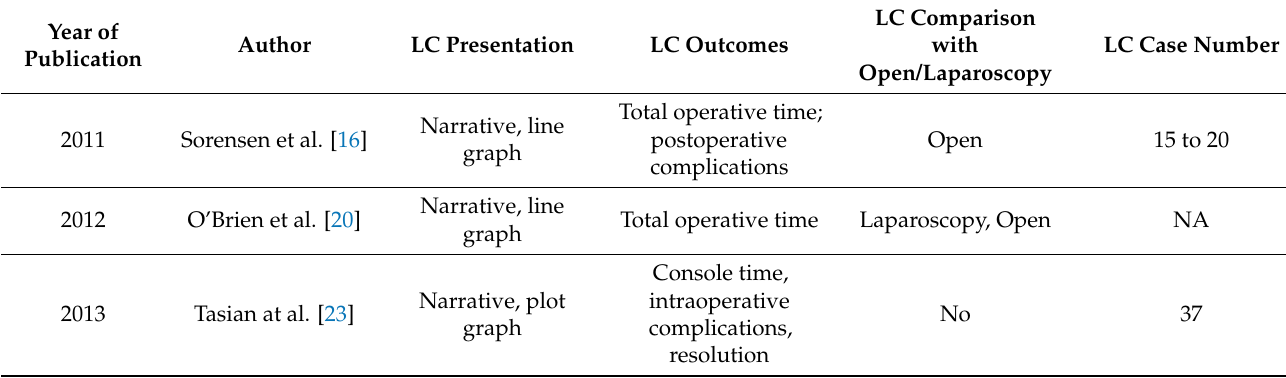
Table 2. Details of learning curves in the included